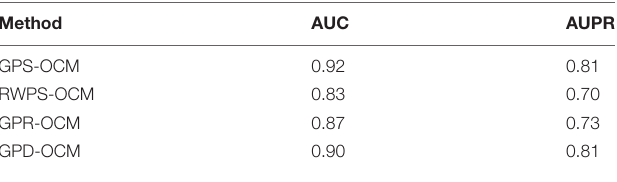
TABLE 1 | Comparison experiment of GPS-OCM and other methods on the “SP”